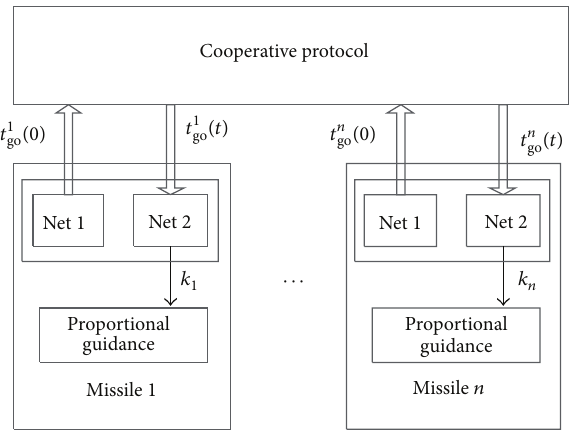
Figure 3: The framework of cooperative guidance strategy.